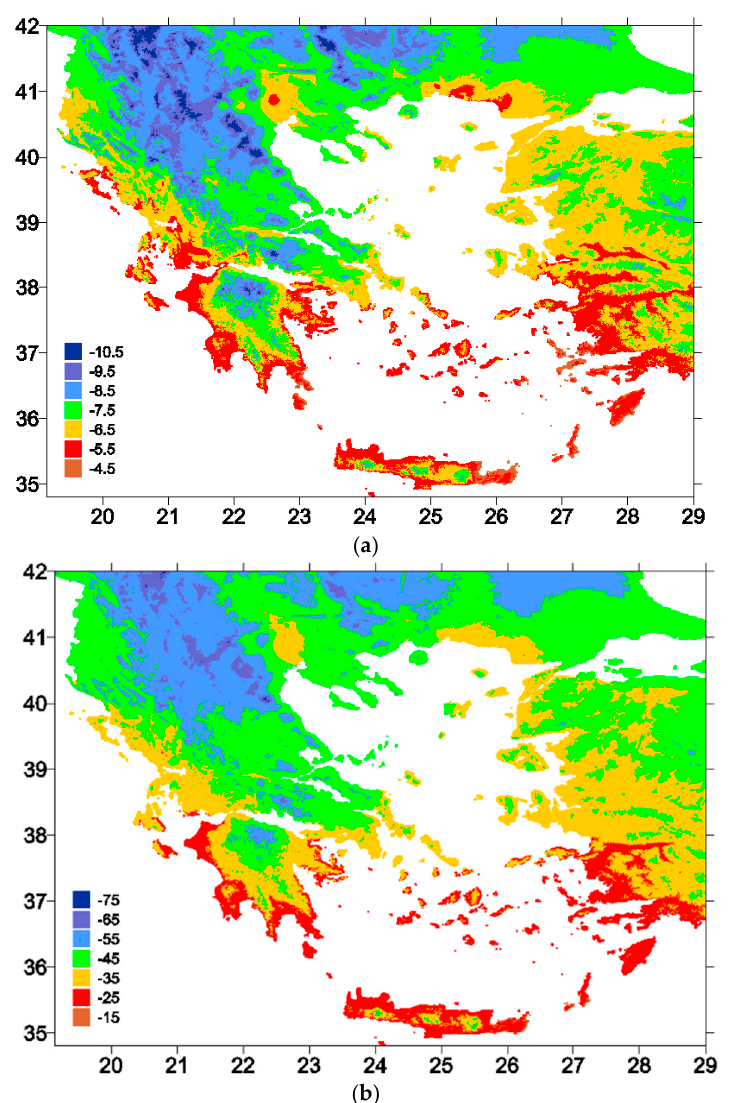
Figure 5. ( a ) The geographical distribution of spring water δ 18 O; ( b ) the geographical distribution of spring water δ 2 H.